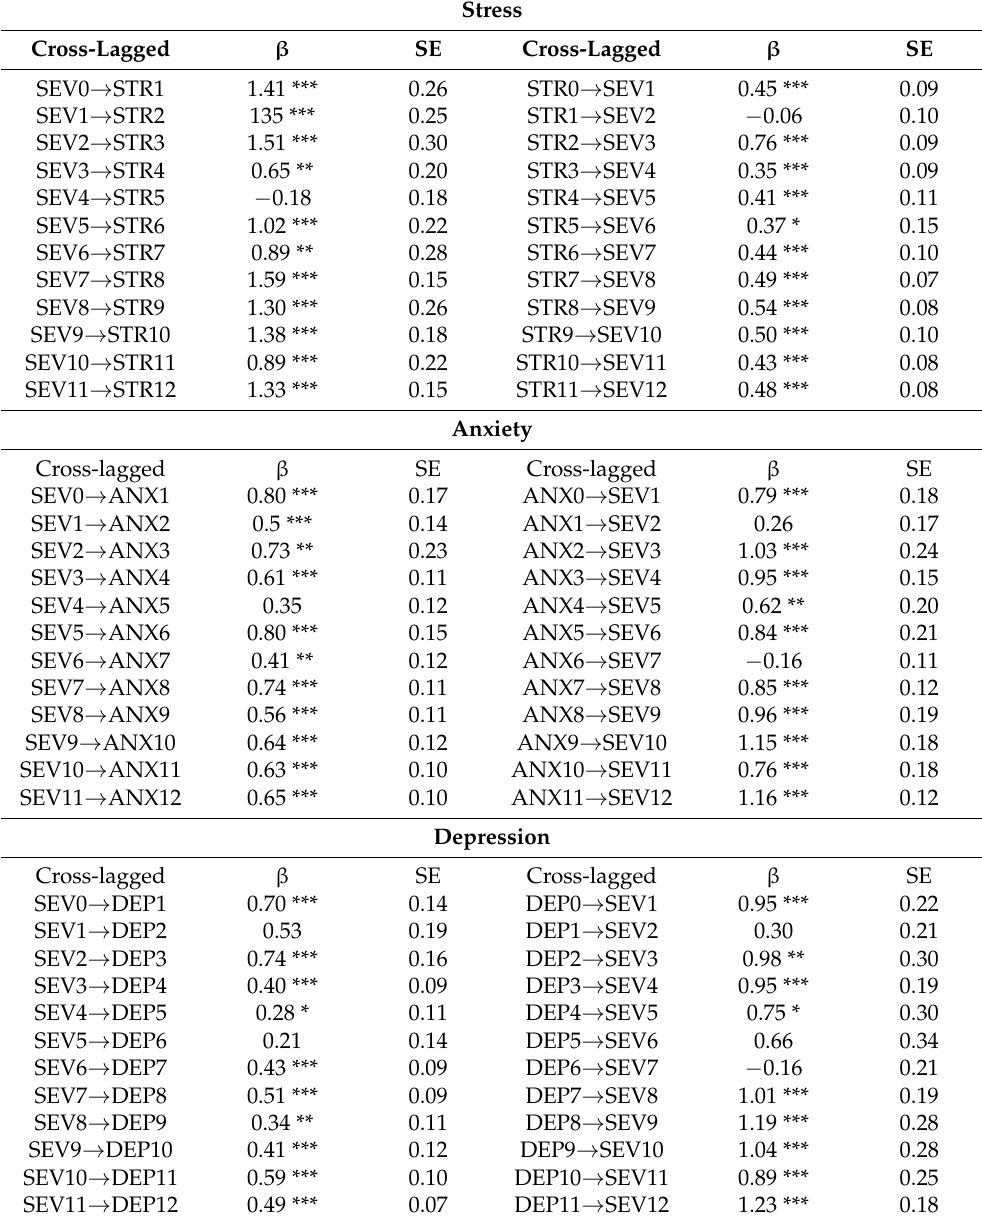
Table 2. Standardized parameter estimates for random-intercept cross-lagged panel models on psychological variables (stress, anxiety and depression) and AD severity (SEV) ( n =